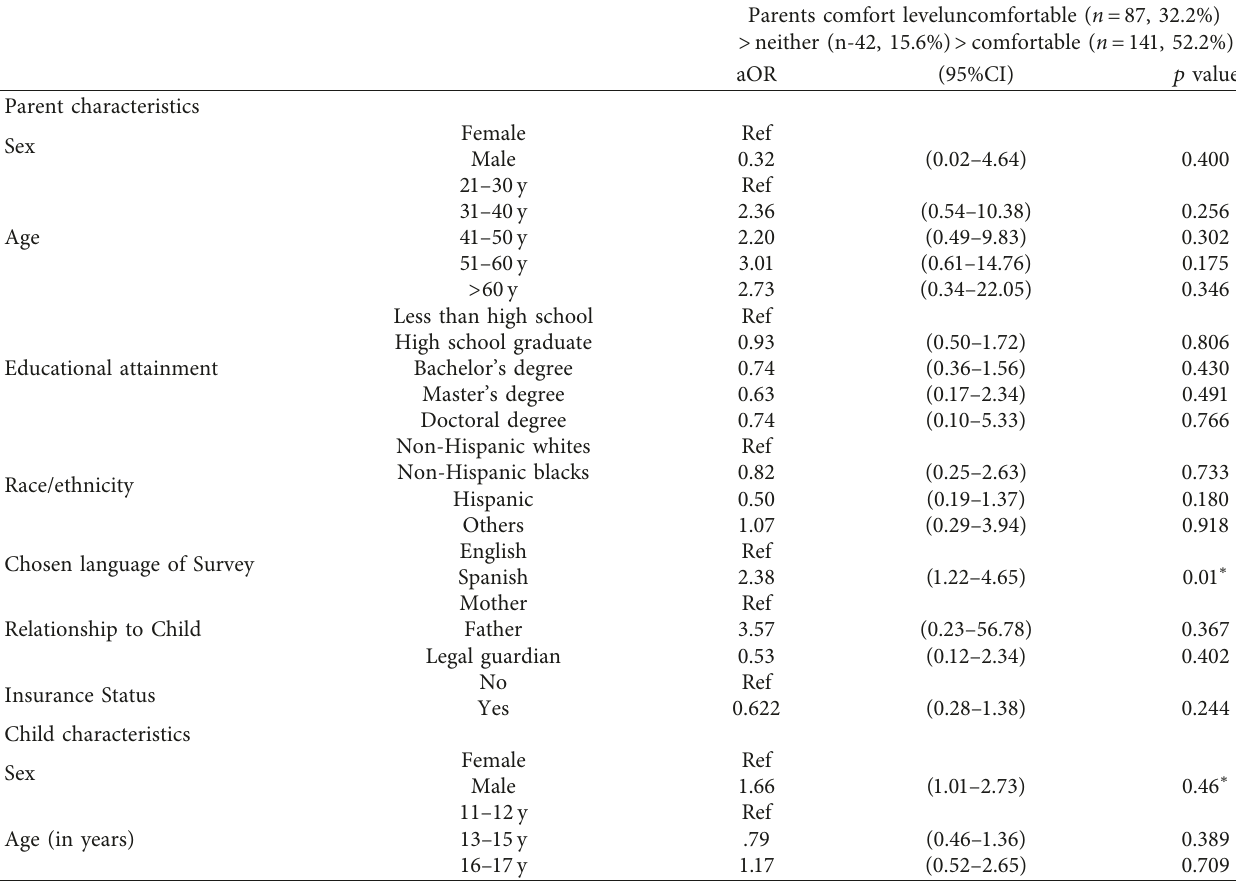
Table 4: Multivariate ordinal logistic regression: association between parent and children characteristics against parents’ comfort level in orthodontics administering HPV vaccination to their children ( N �